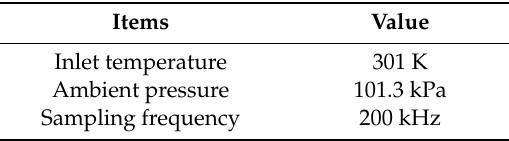
Table 3. Operational conditions of the test.